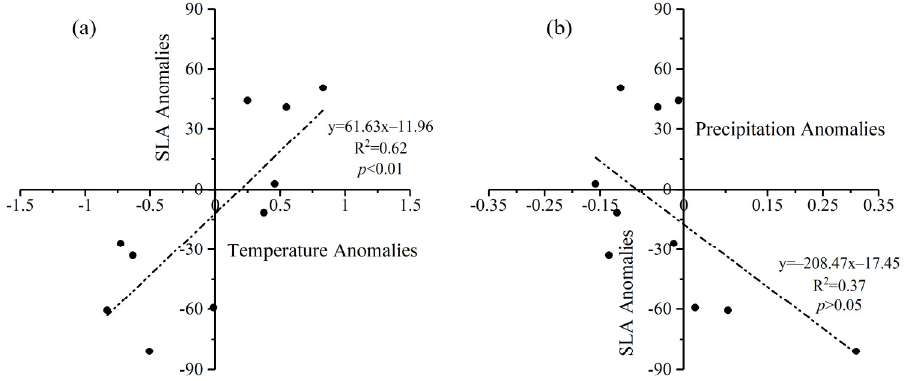
Figure 10. Average snowline altitude anomalies plotted versus air temperature anomalies ( a ) and solid precipitation anomalies ( b ) on the Muz Taw Glacier during 2011–2021.